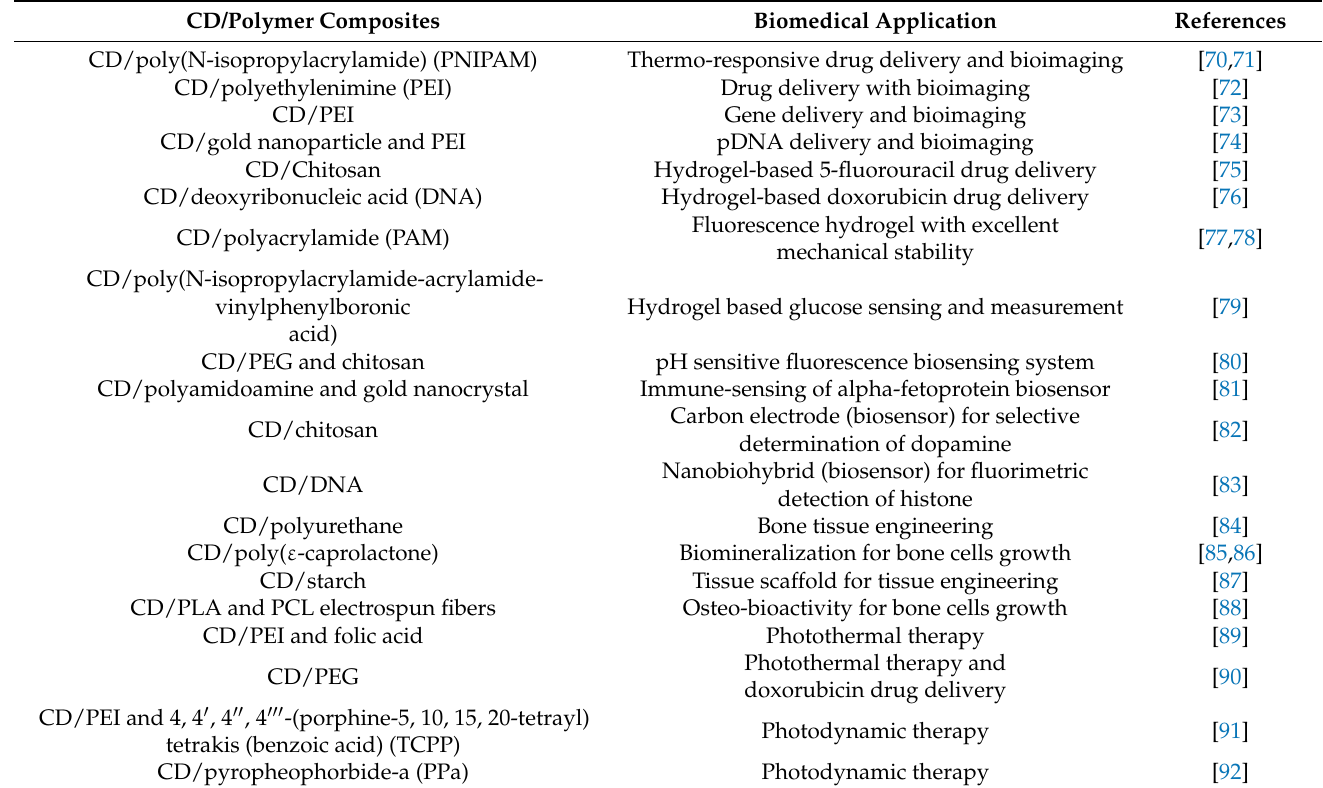
Table 1. Representative biomedical applications of carbon dot/polymer